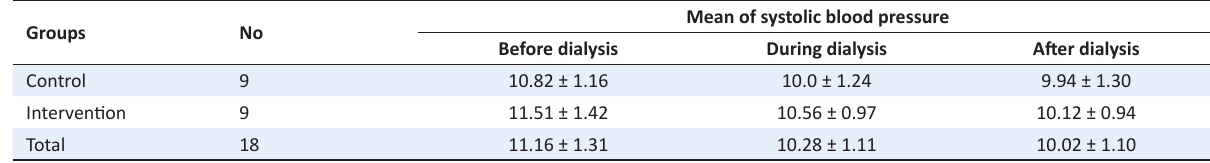
Table 1. Effect of sertraline on systolic blood pressure before, during and after dialysis Groups